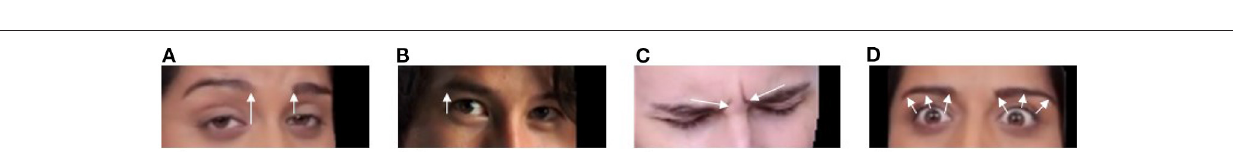
FIGURE 1 | The facial landmarks measured by OpenFace, exemplified for the first frame of the video featuring speaker PL (Lester, 2018). The eyebrow-specific landmarks are highlighted in red, and the numbers used in the analyses to refer to the landmark coordinates are indicated. The green lines represent distances measured between two facial landmarks.